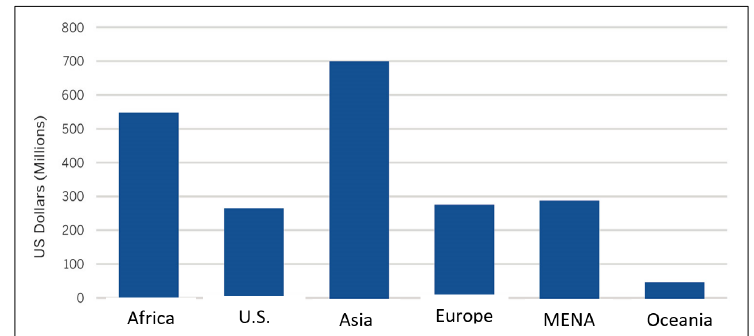
Figure 1: ODA Recipien Countries in the Asia Region that Received ODA in 2010-2017 Source: World Bank